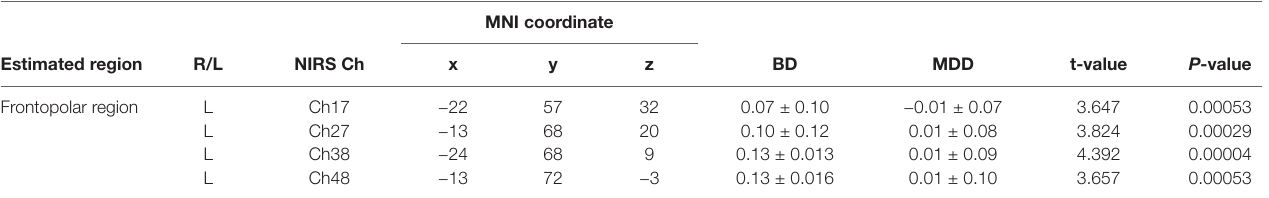
TABLE 2 | Comparison of VFT-related oxy-Hb changes of patients with bipolar disorder and those with major depressive disorder threshold, with Bonferroni-corrected P <